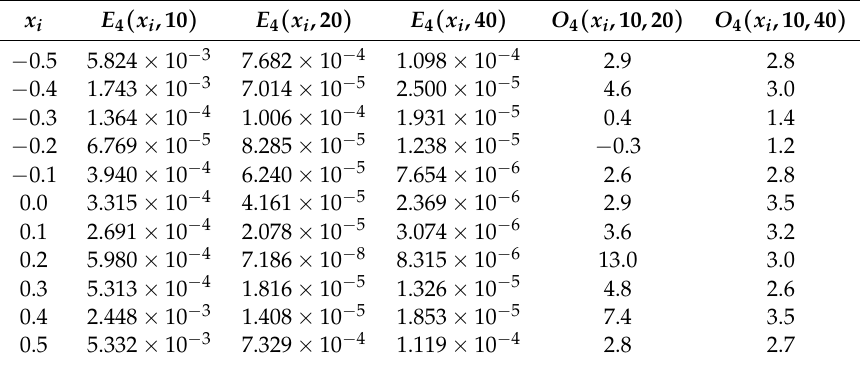
Table 12. The absolute errors of the fourth order derivatives of y 2 at the knots and the numerical convergence